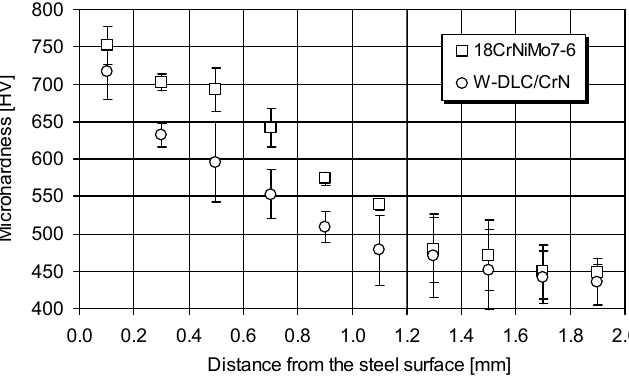
Figure 19. Microhardness profiles before and after deposition of the W ‐ DLC/CrN coating.